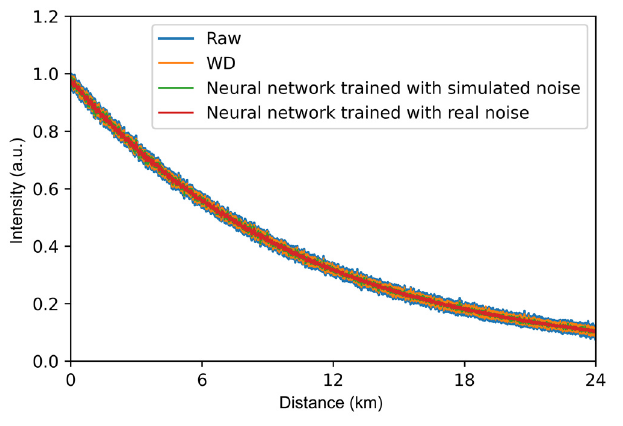
Figure 7. The raw AS signal and denoised results.